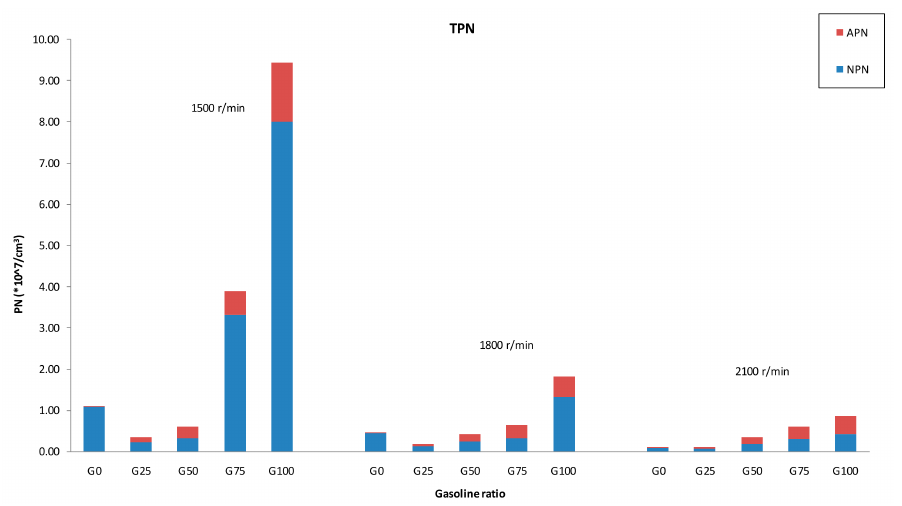
Figure 9. Total particle number with R e for di ff erent speed (The direct injection timing is 180 ◦ CA BTDC. The ignition timing is MBT. The intake manifold absolute pressure is 42